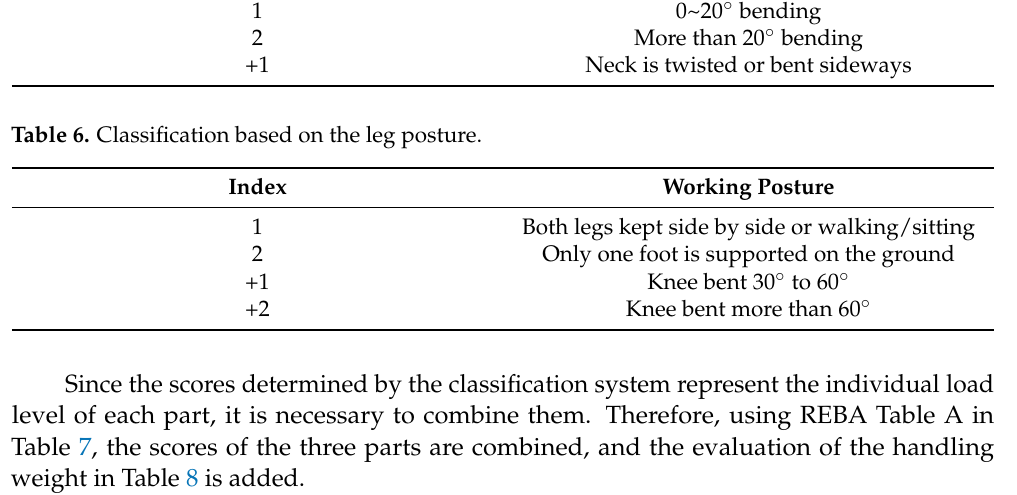
Table 7. Scoreboard for REBA Table A (waist, neck, legs). Neck